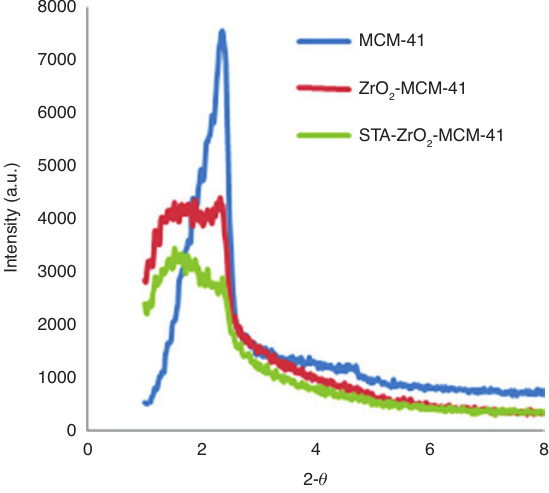
Figure 1: XRD patterns of MCM-41 and MCM-41 supported catalysts.